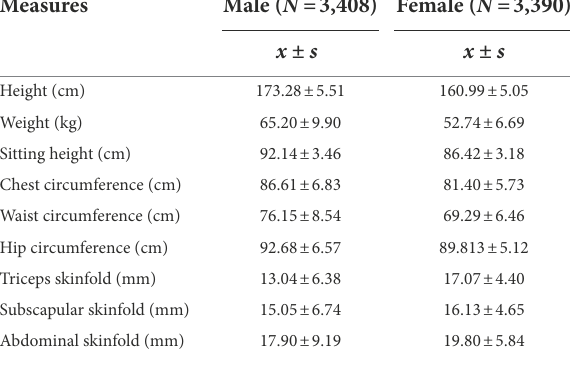
TABLE 1 Anthropometric measures of participants.